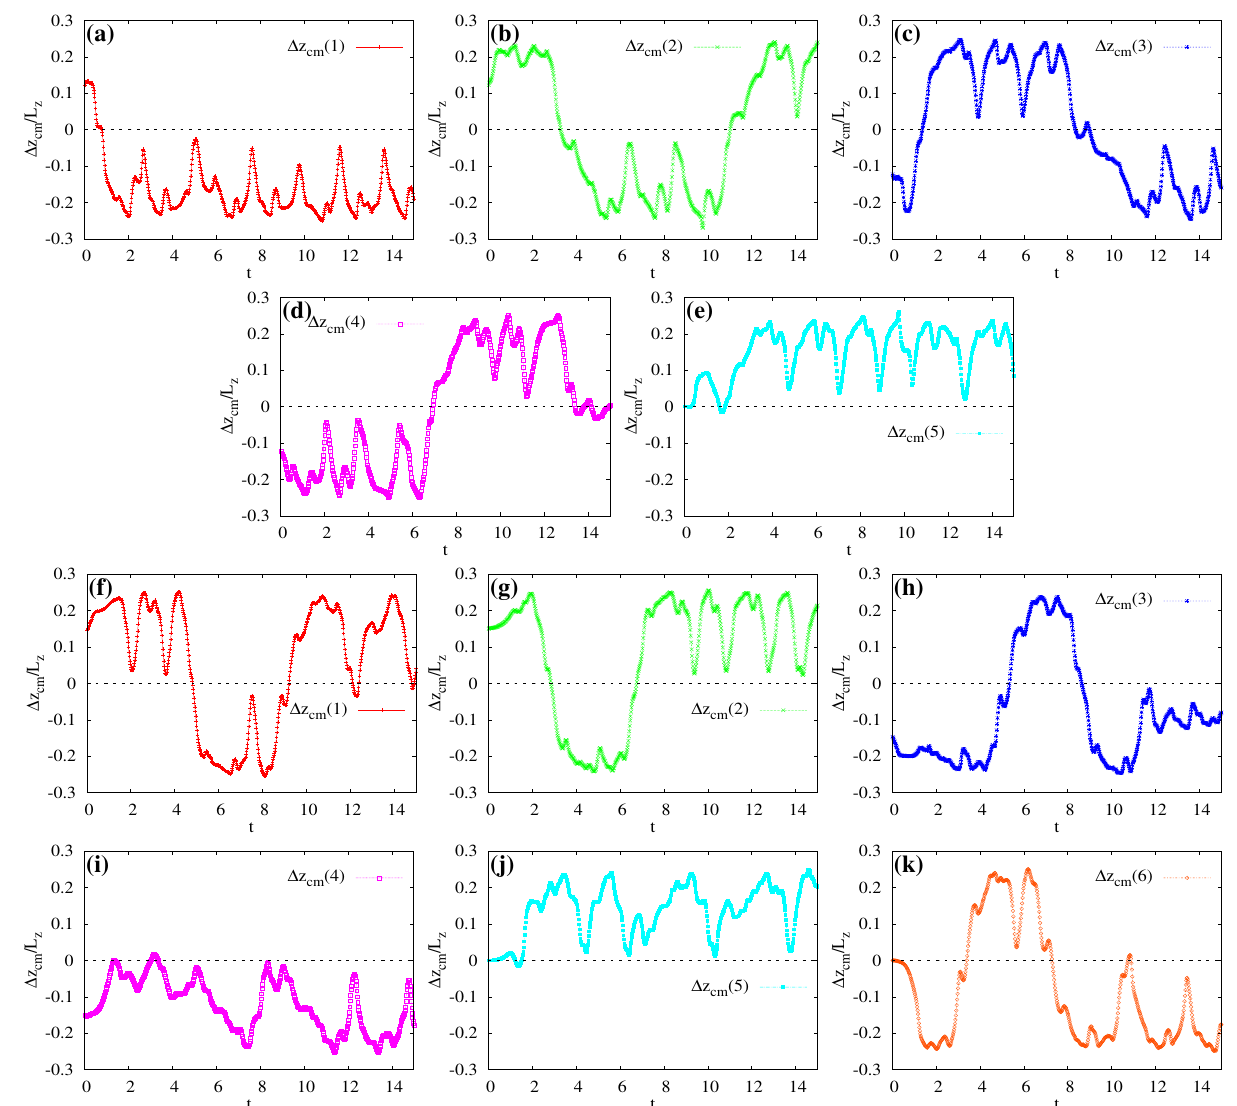
Fig. 10 Multiple crossings in fi ve and six-core emulsions. a – e Time evolution of the dislpacement Δ z cm of the cores in a fi ve-core emulsion. Regular periodic motion survives for short periods of time and is temporarily broken by crossings of the cores towards either the top or the bottom of the emulsion. f – k Time evolution of Δ z cm in a six-core emulsion. Although some cores travel along approximately similar trajectories (such as 1, red/plusses, and 2, green/crosses), there is no evidence of a persistent coupled periodic motion involving two (or more) drops. The black dotted line is a guide for the eye indicating the separation between the two regions of the